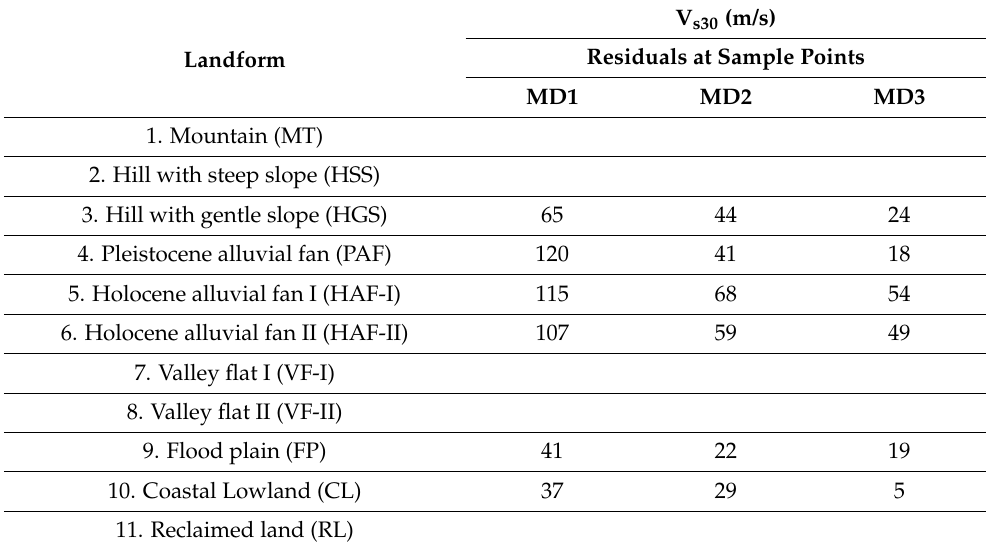
Table 5. Unsigned deviations between measured V s30 (SPAC, MASW) and estimated values at those sampling points, averaged within each geological unit. V s30 estimation methods: Wald and Allen (2007) [23] for tectonically active regions (MD1); Equation (7) (MD2); Equation (8)